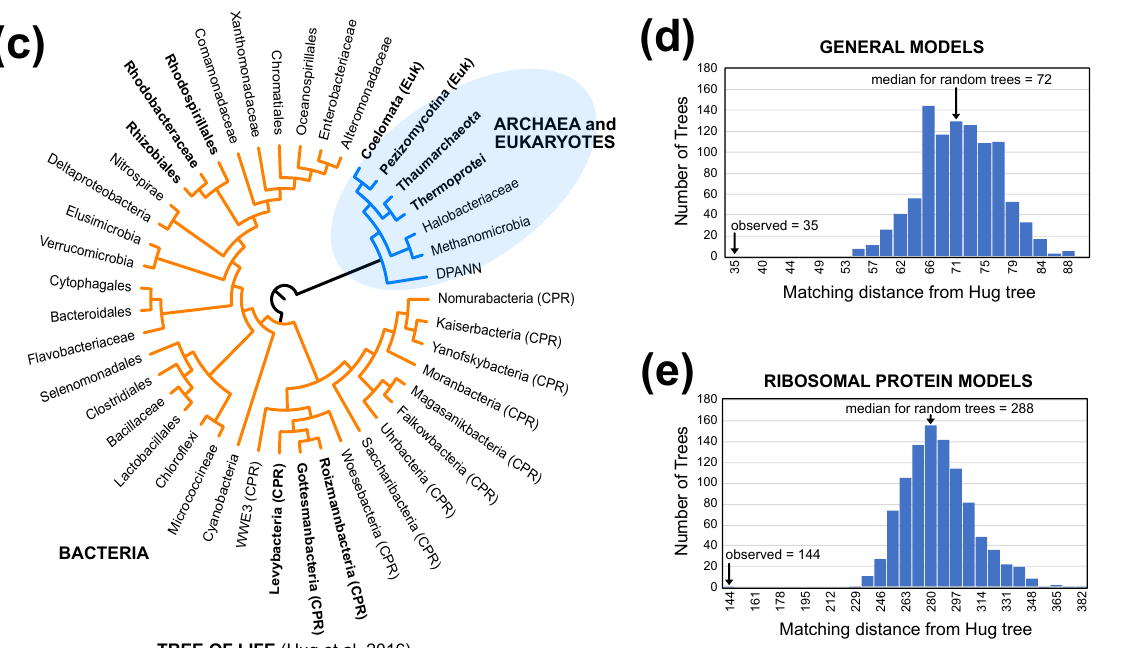
TREE OF GENERALIZED MODELS